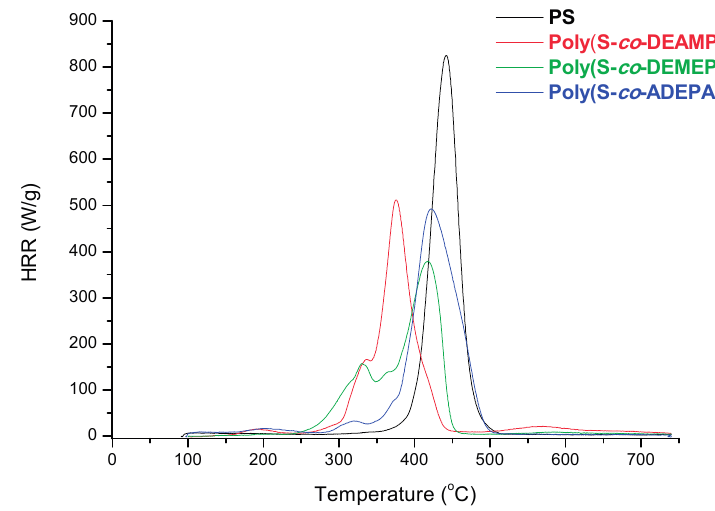
Figure 7. Plots of HRR versus temperature for PS, poly(S- co -DEAMP), poly(S- co -DEMEP) and poly(S- co -ADEPAE).